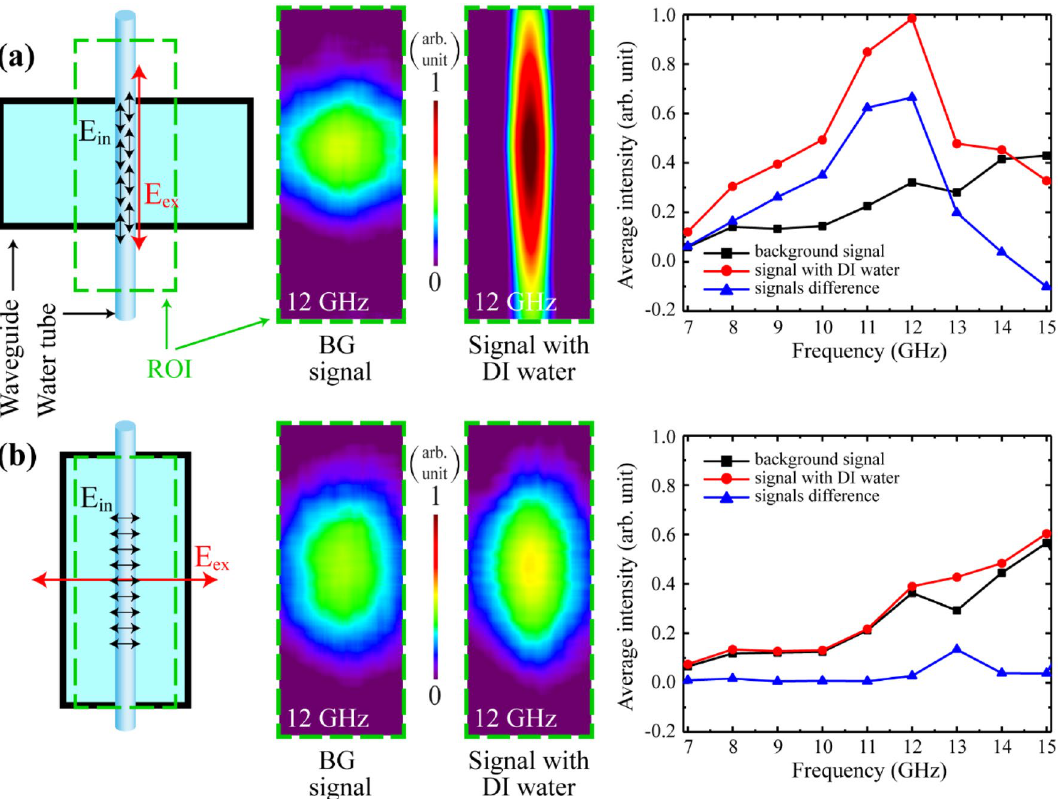
Figure 3. Illustration of the experimental configuration with different waveguide orientations, when ( a ) E-field polarization is parallel to the direction of a tube, and ( b ) E-field polarization is perpendicular to the tube orientation. From left to right shown experimental configuration and green dashed rectangle corresponds to the region of interest (ROI). Next two images show the visualization results of the H-MWNF distributions of the BG signal and for the plastic tube with DI water at the frequency of 12 GHz. The last graph includes information about changes in the average intensity values of the H-MWNF distribution of BG signal (black), the signal with DI water (red) and information about differences of these two signals (blue) in 7–15 GHz frequency